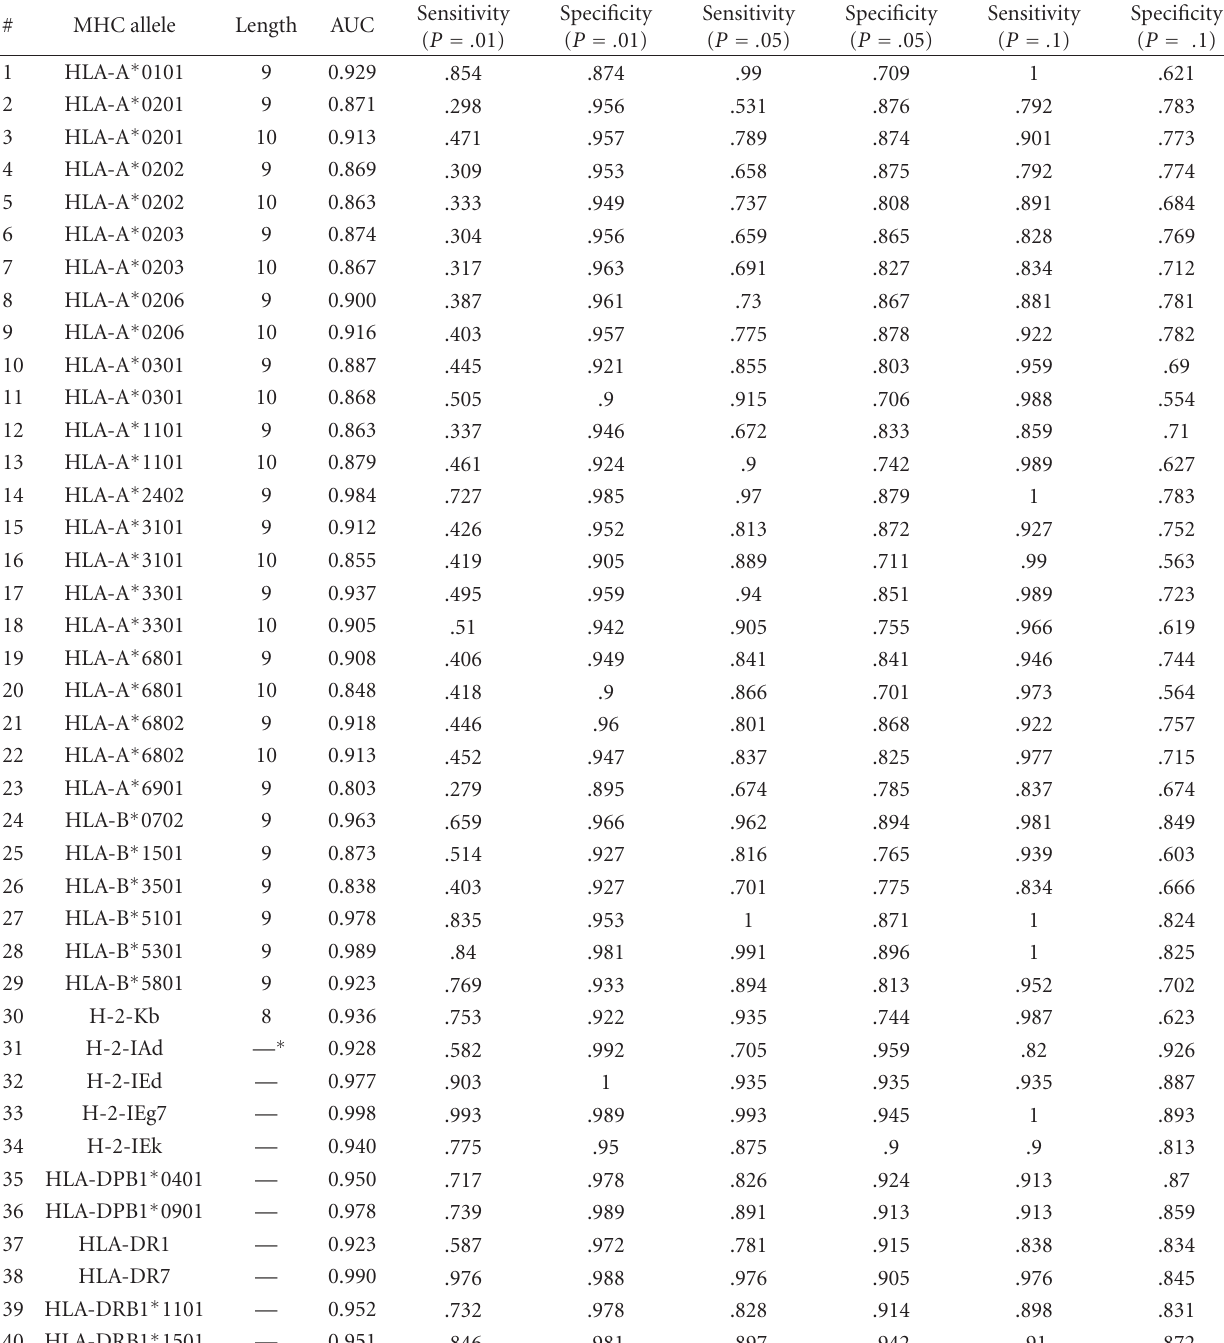
Table 2: Epitope prediction performance by Vaxitope as measured by AUC